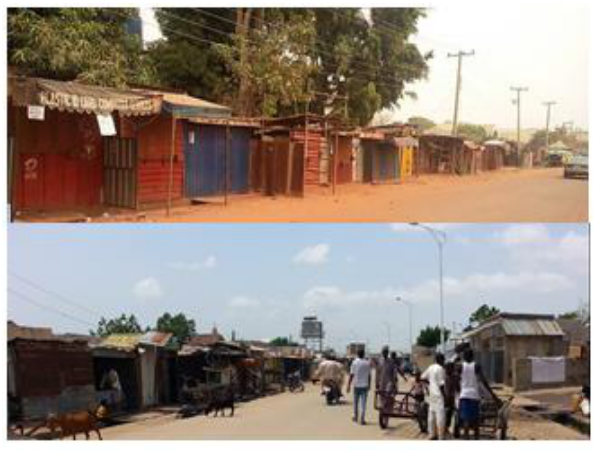
Figure 7& 8: These are areas with tacit approval for vending activities. Different stall typologies exist at different stages of development, despite been at different locations. 6 providing different computing services and accessories is located at the CBD in Kaduna, off Yakubu Gowon Way, while 7, selling food and other perishable goods, is at the outskirts of Sheka district. Source: Authors